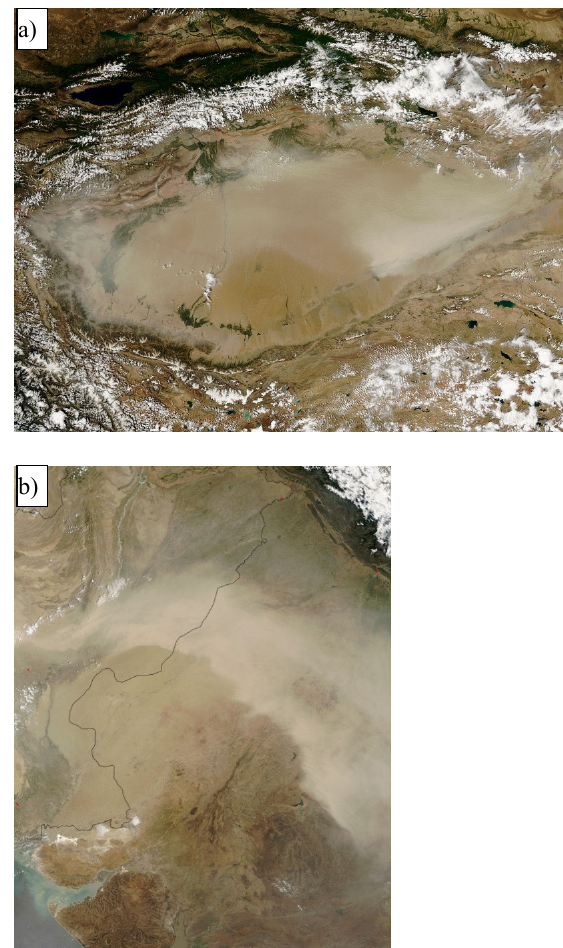
Figure 5 : MODIS image of dust storm over Takla Makan desert, northern slopes of Tibetan plateau (a) and Thar desert, north-western part of India (b), source: VISIBLE EARTH NASA Image .